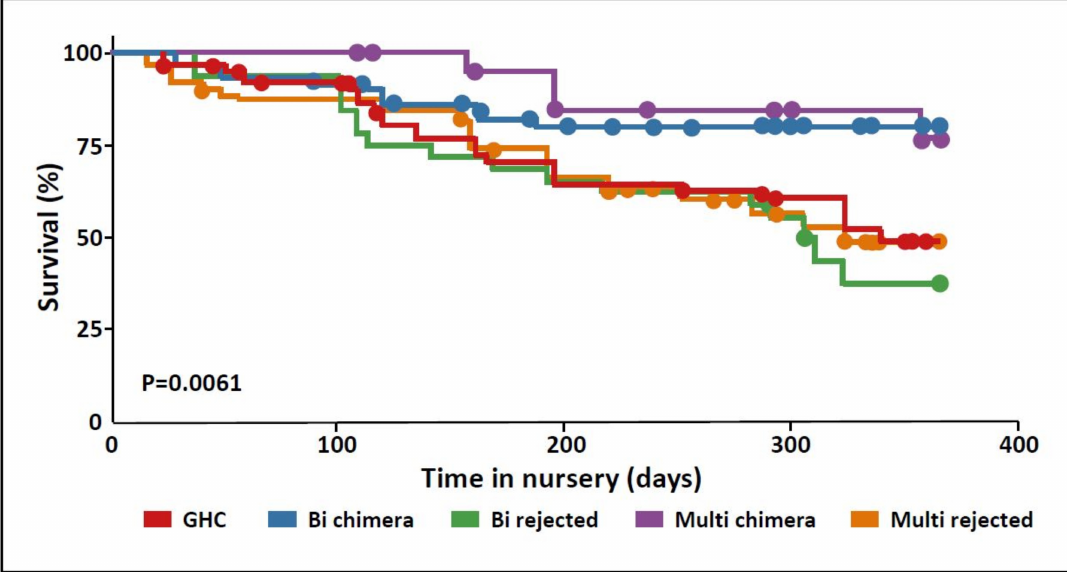
Figure 3. Kaplan–Meier survival curves (with the p value) for all colony types along a period of one-year in the midwater coral nursery under ambient field conditions. The Y -axis depicts the cumulative survival probabilities and the X -axis is the time in the nursery in days. Circles on lines indicate census